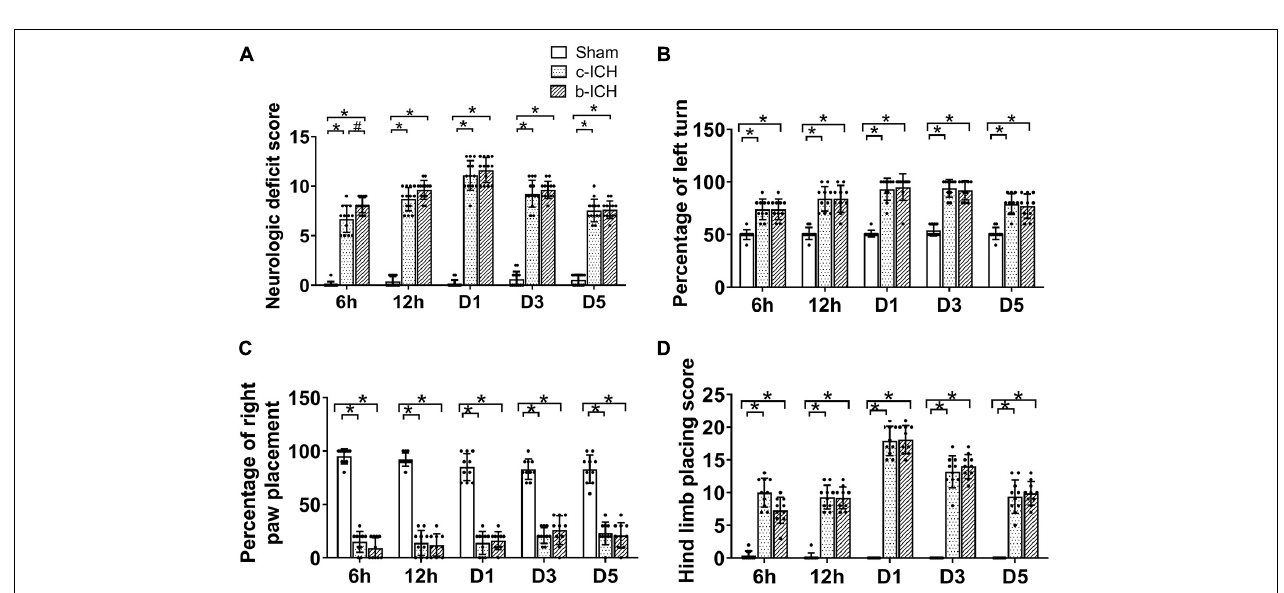
FIGURE 2 | Motor function of the two ICH models. (A) Mice in the b-ICH group had a more severe neurologic deficit score (NDS) than the c-ICH group at 6 h after ICH. n = 10 mice/group. * P < 0.05 vs. sham group; # P < 0.05 vs. ICH group (repeated measures ANOVA followed by Bonferroni post-hoc test). (B–D) The corner turn test and right front paw and hindlimb placement tests on 6 h, days 1, 3, and 5 after ICH. n = 10 mice/group. * P < 0.05 vs. sham group (the repeated measures ANOVA followed by the Bonferroni post-hoc test). Values are mean ±